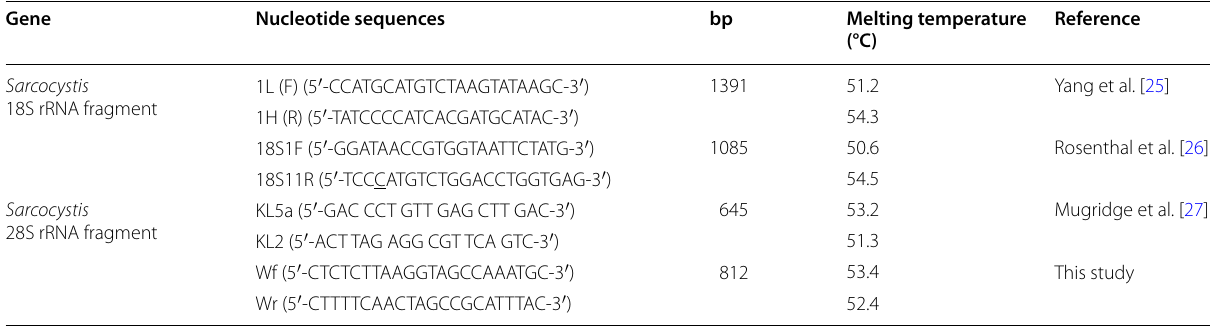
Table 1 Primers used for amplification of DNA extracted from the identified sarcocysts using 18S and 28S rRNA regions, with expected amplicon size and melting temperature (MT) Gene Nucleotide